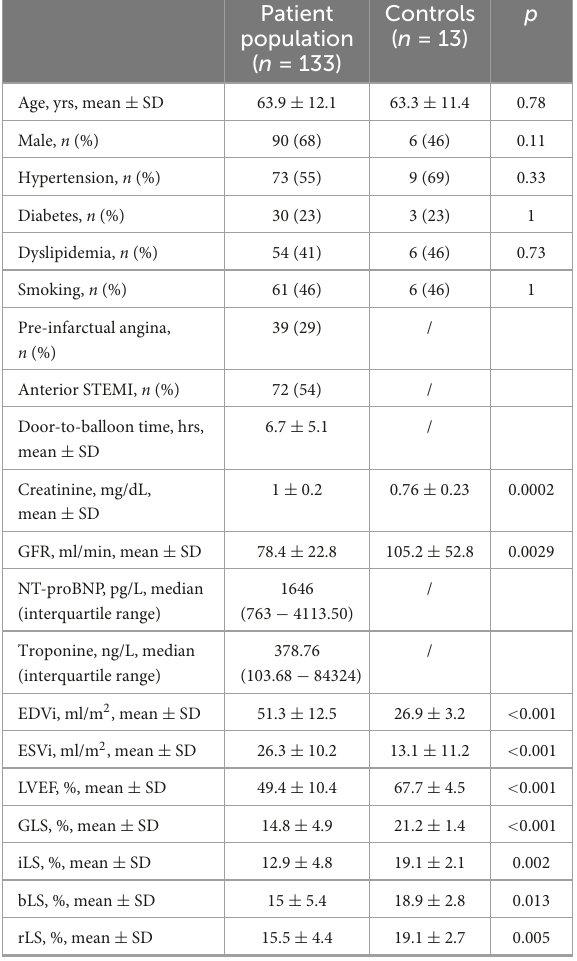
TABLE 1 Clinical and echocardiographic data in patients and in controls at